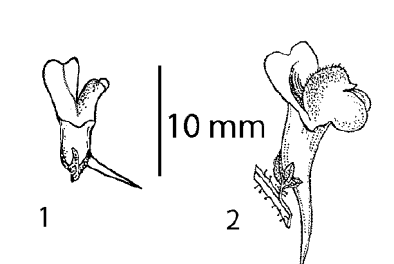
Рис. 2. Цветки: 1. L. vulgaris subsp. pinetorum , 2. L. vulgaris subsp. vulgaris . Настоящие мелкотравные, опустыненные и солонцеватые степи, обочины дорог. Россия : Урал (Южн.), Зап. Сиб. (Ирт., Обск., Алт.), Вост. Сиб. (Анг.-Саян.), Дальн. Вост. (Зее-Бур.); Казахстан (Тоб.-Ишим., Ирт., Зап. и Вост. мелкосоп.). Общее распр. : Кавказ (Дагестан), Казахстан, Ср. и Вост. Евр. Примеч . В настоящее время вид обнаружен в составе степных сообществ в Новосибирской, Кемеровской